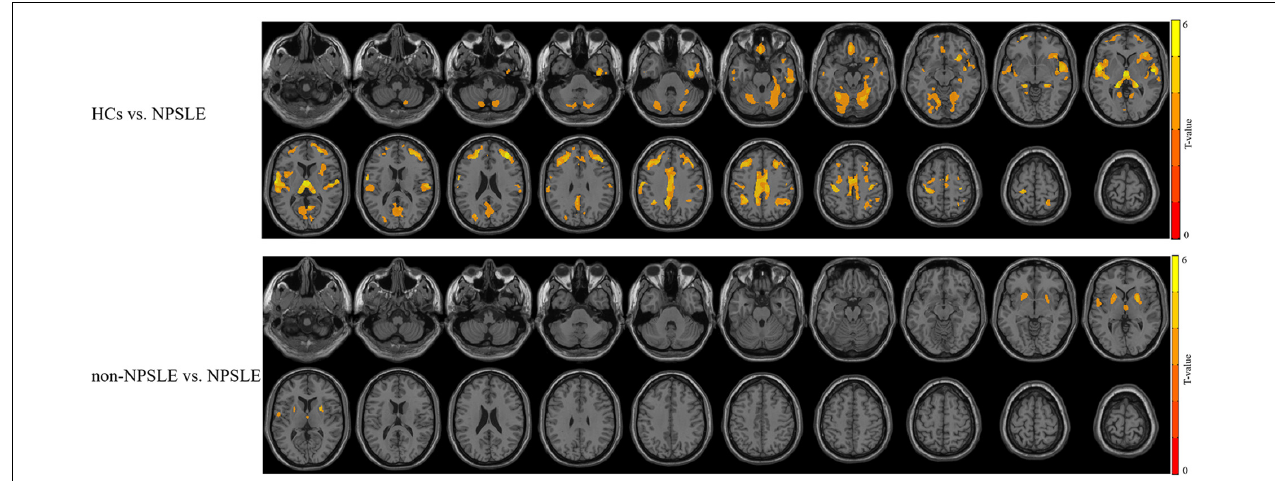
FIGURE 1 | The different patterns of GM atrophy in patients with NPSLE and non-NPSLE. The colored bar indicates the statistical T distribution between groups.